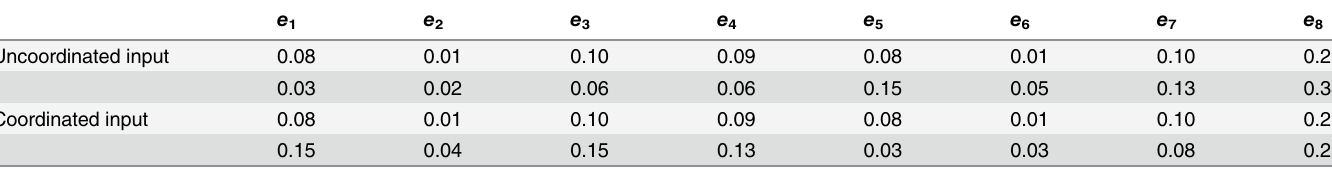
Table 1. Inputs for each muscle in the simulation experiments.